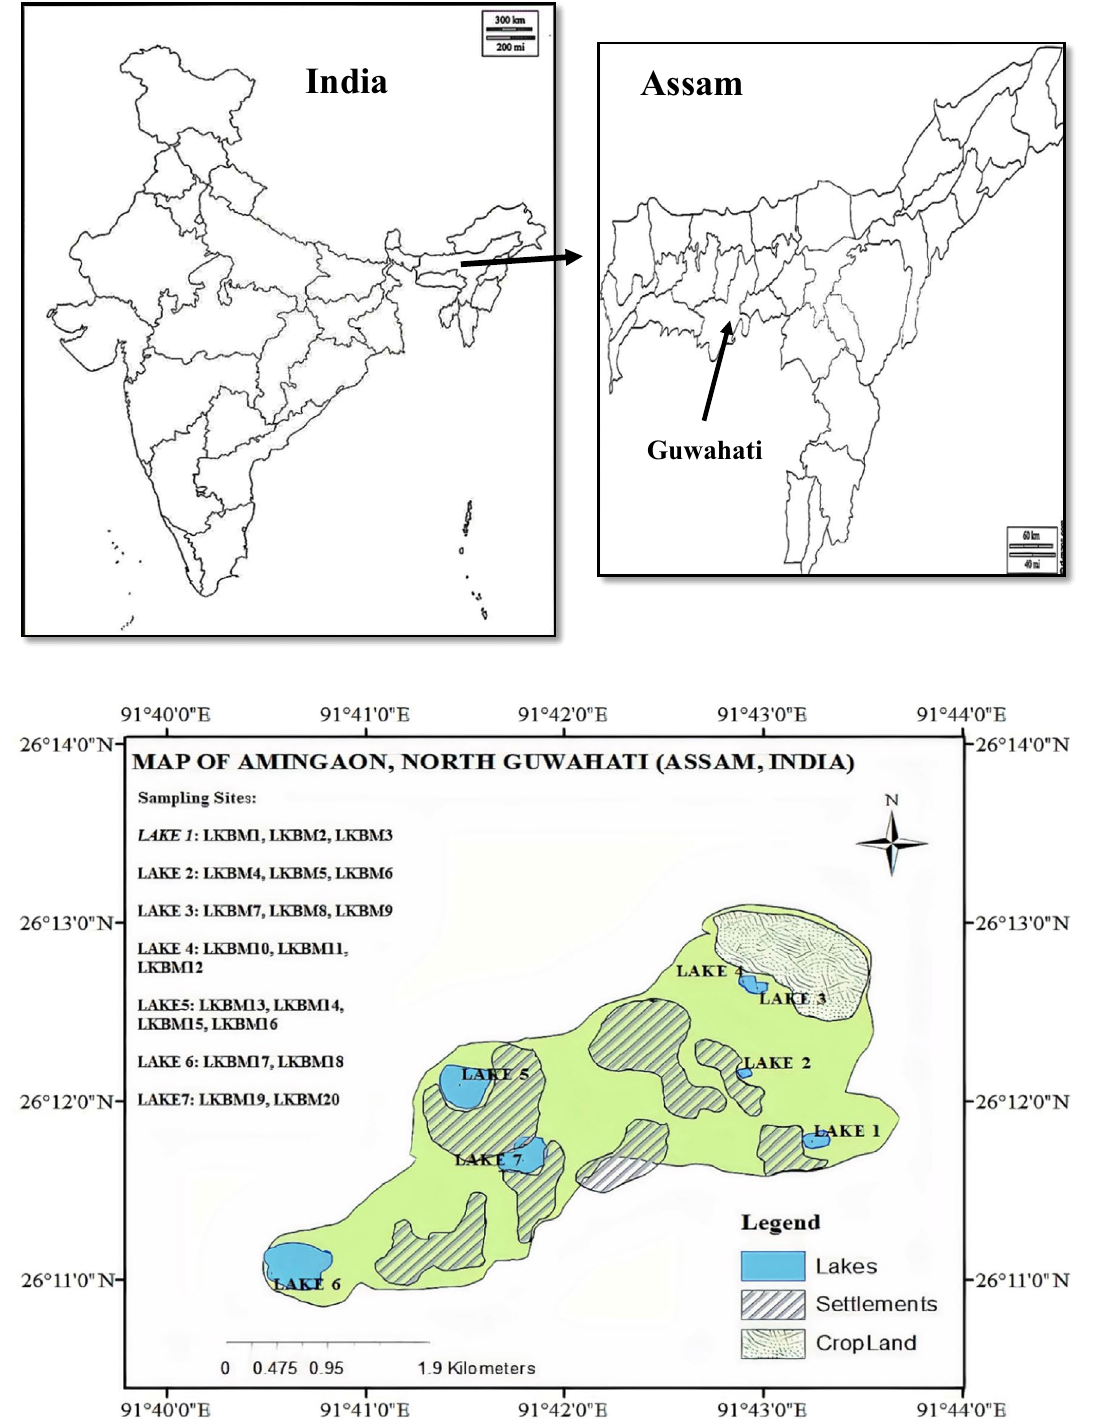
Fig. 1 Location of sampling sites in north Guwahati (Assam, India) (delineated using ArcGIS-ArcMap (v.